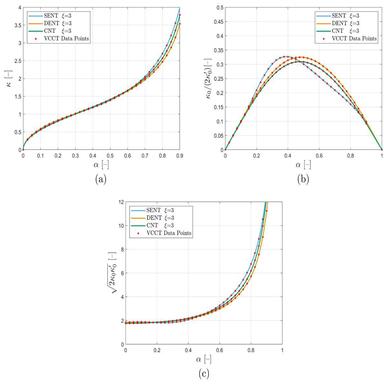
Fittings for: (a) κ; (b) intrinsic size factor; and (c) intrinsic nominal strength factor, using the vectors χ , Φ, Ψ of Appendix B, and the original VCCT data points obtained from the FE analyses. Plots showing variation of these factors for the three geometries of interest, all with a value of ξ = 3.